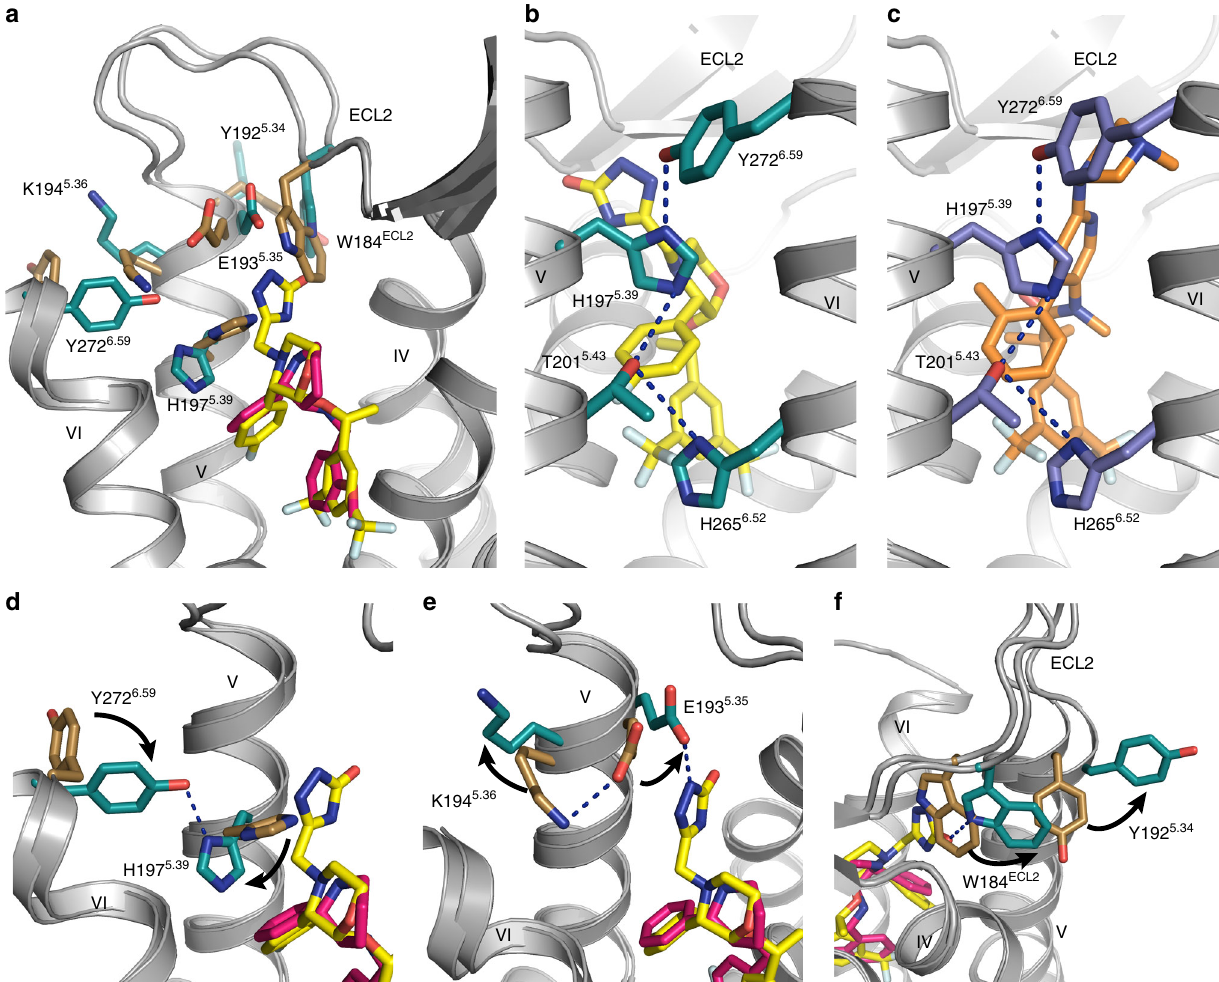
Fig. 3 Conformational changes in NK 1 R induced by clinically used antagonists. a Superimposition of the CP-99,994- and aprepitant-bound NK 1 R structures, viewed from helix I. Residues of NK 1 R with side-chain orientations differing between the two receptor structures as well as the antagonists are depicted as sticks, coloured as in Fig. 1. b , c Hydrogen bond network connecting the extracellular ends of helices V and VI in the aprepitant- ( b ) and netupitant-bound ( c ) NK 1 R structures as viewed from the membrane plane. Hydrogen bonds are indicated as dashed blue lines. d – f Close-up views on residues with differing side-chain orientation in the CP-99,994- and the aprepitant-bound NK 1 R structure. Side-chain rearrangements from the CP-99,994- to the aprepitant- bound conformation are indicated by black